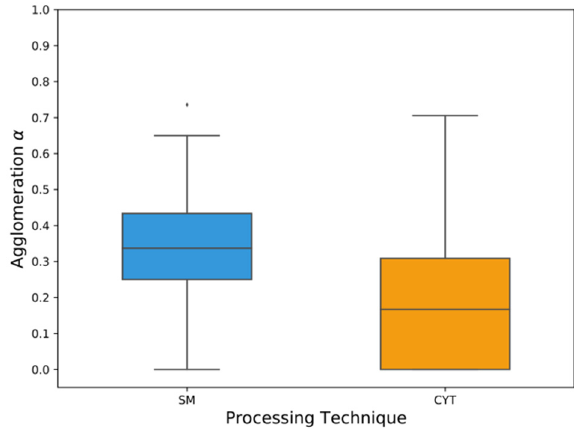
Figure 9. Agglomeration distributions comparison.